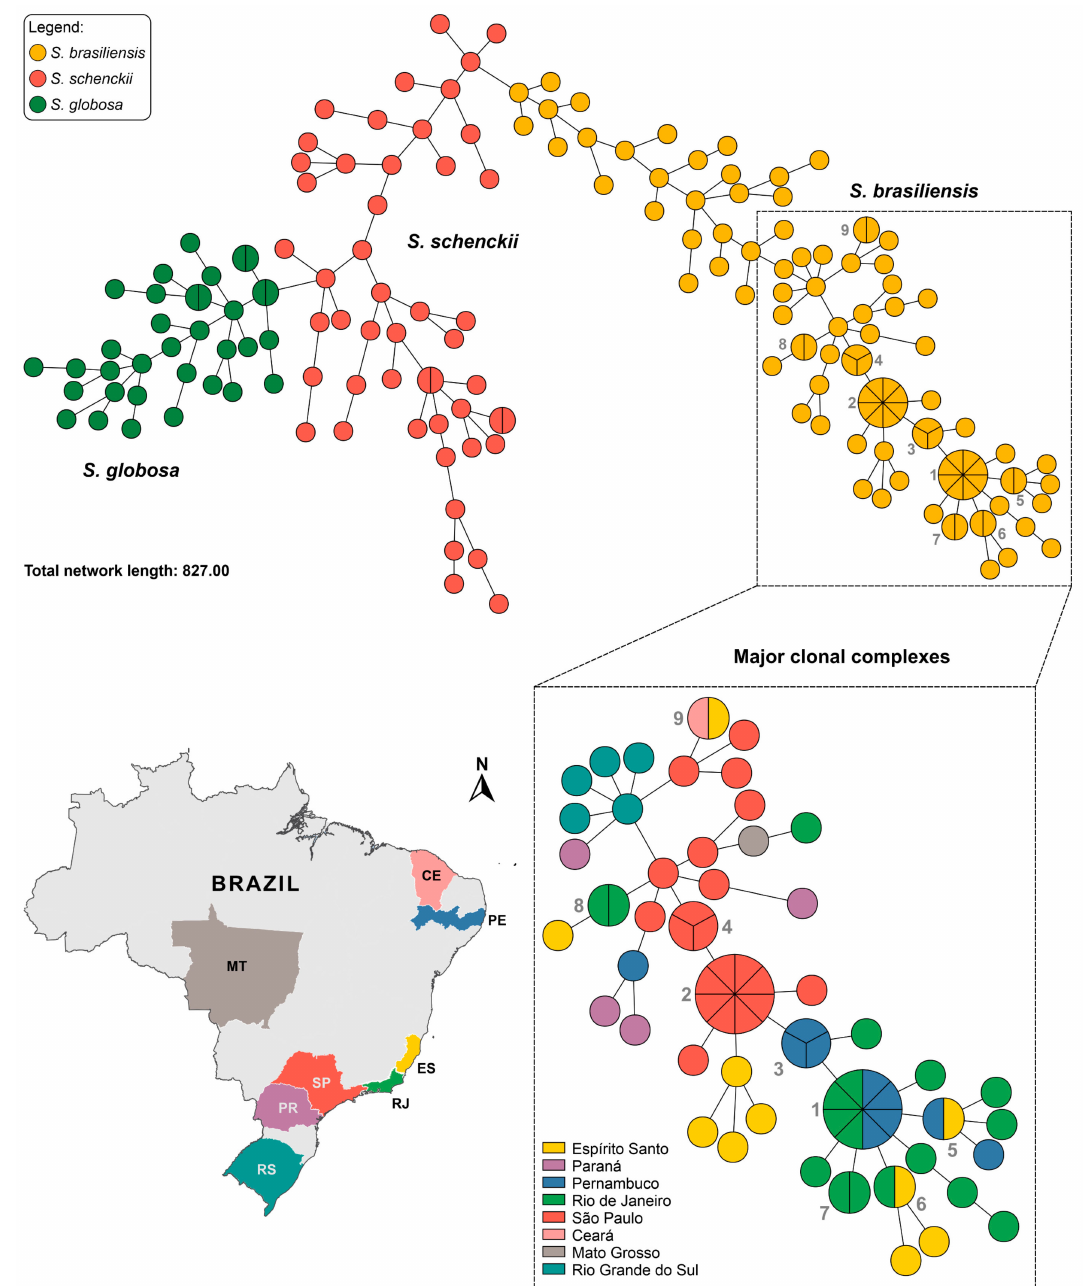
Figure 9. Minimum Spanning Trees (MSTs) showing the genetic relationship among 180 Sporothrix isolates using 15 SSRs markers. MST was created in the software BioNumerics v7.6. The annotated figure with all isolates is shown in Supplementary Figure